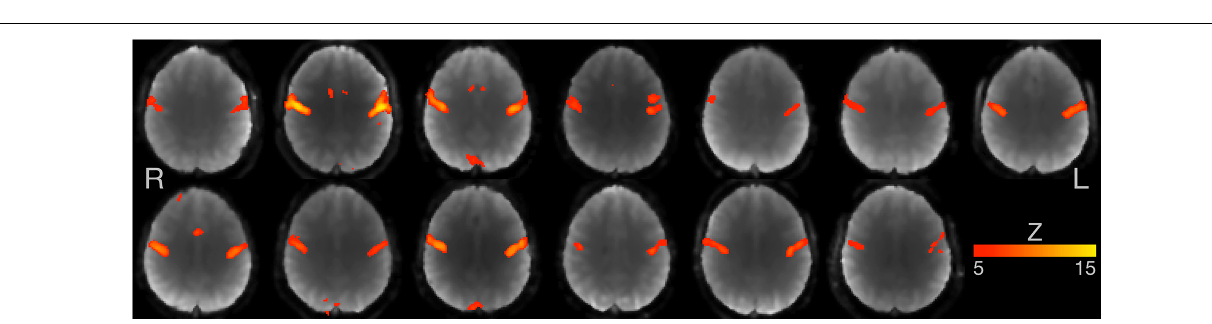
FIGURE 2 | Results of the group independent component analysis (ICA). The five components with the highest explained variance are shown on axial slices in separate rows. Brain activity is color-coded in red and yellow. Images are in radiological convention (the left hemisphere is seen on the right).